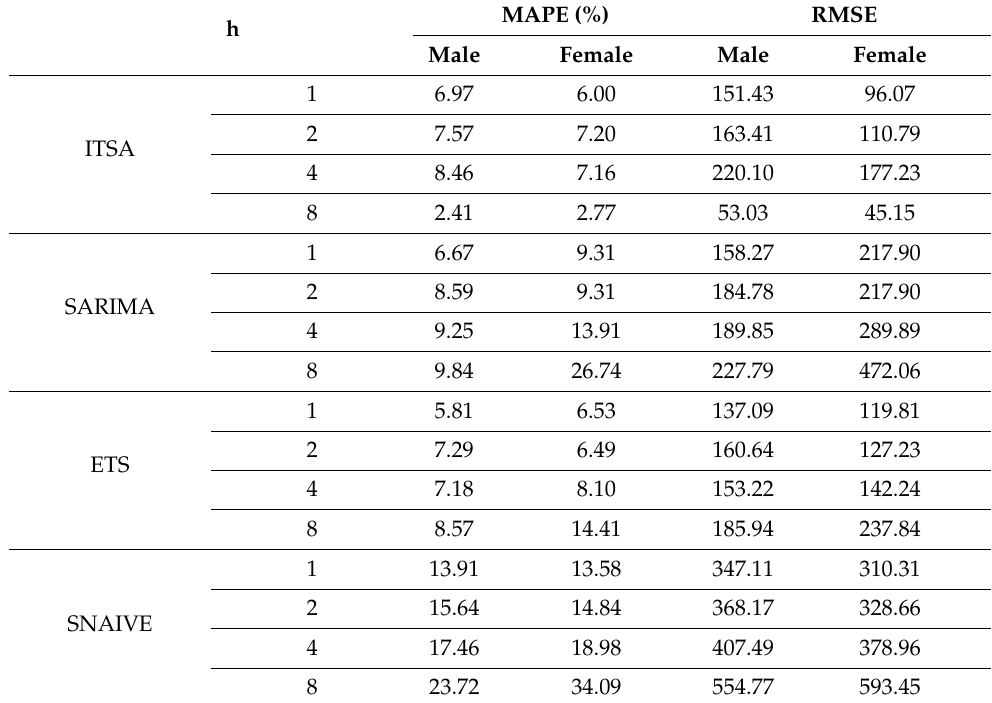
Figure 17. Forecasts of female donor transplants from September 2020 to May 2021 using ITSA, SARIMA without intervention, ETS, and SNAIVE. Table 9. Forecast accuracy measures by gender at various forecast